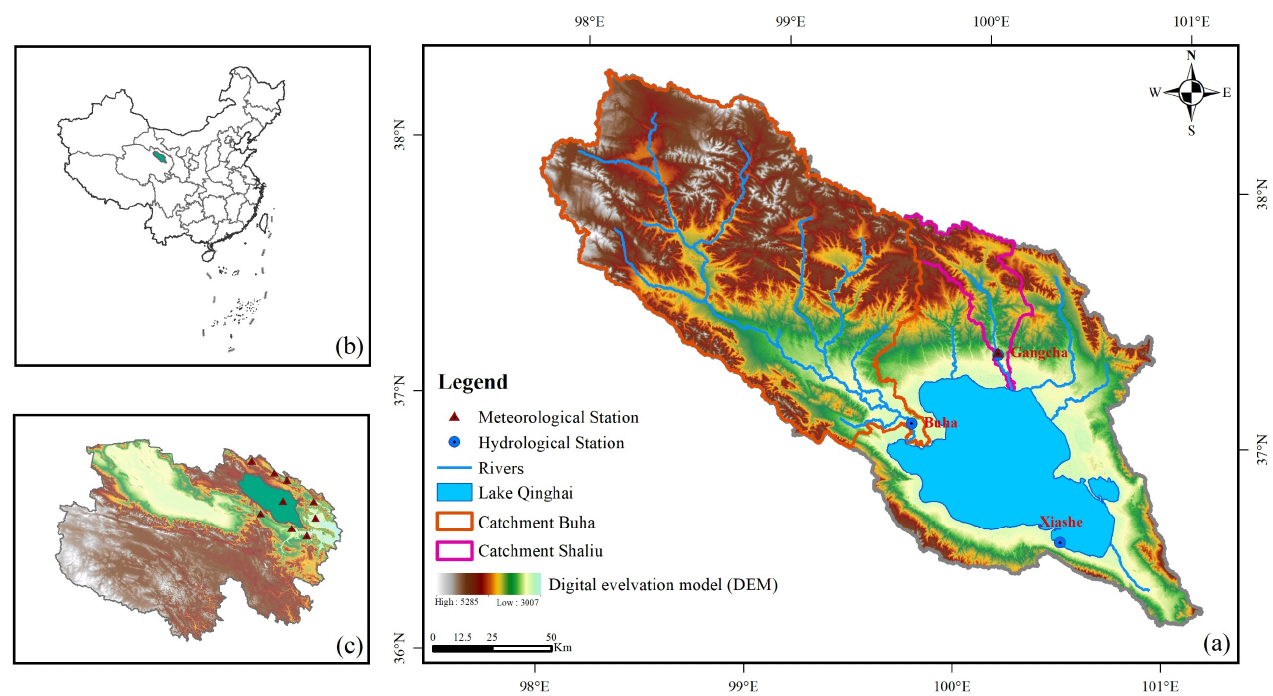
Figure 1. Location of the study area in ( a ) the Lake Qinghai catchment, and the catchment in ( b ) China and ( c ) Qinghai Province. The triangles in panel ( c ) show the location of meteorological stations in or around the catchment and colors indicate elevation.